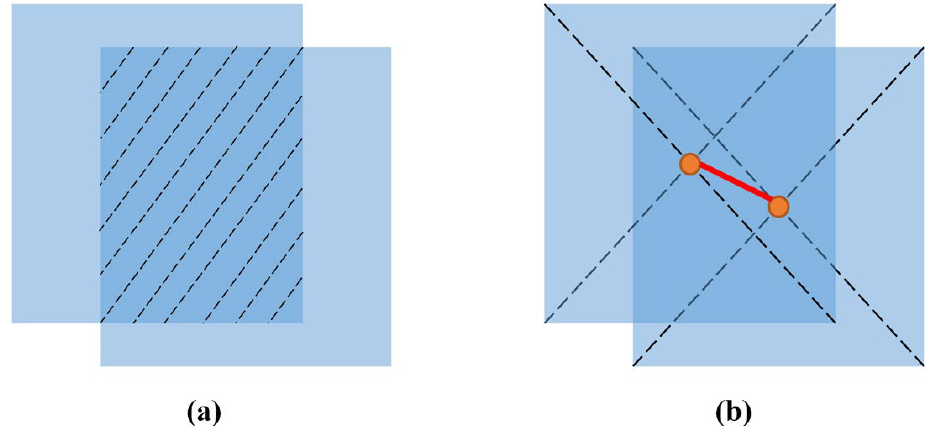
Figure 5. ( a ) IoU matching; ( b ) central point matching.